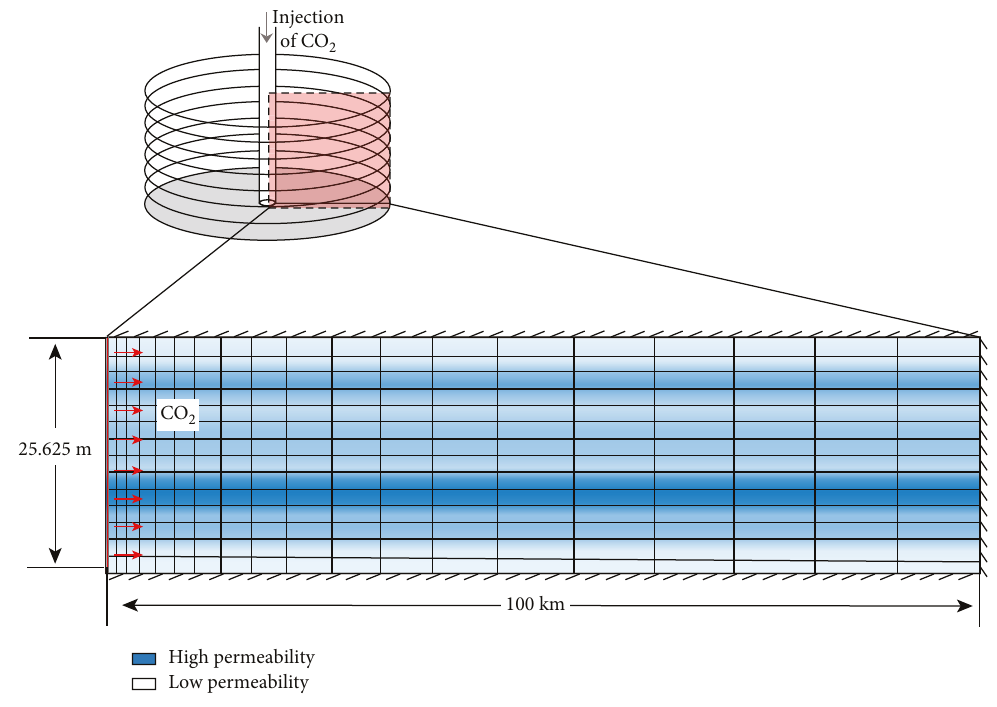
Figure 6: Schematic diagram of the radial model for CO